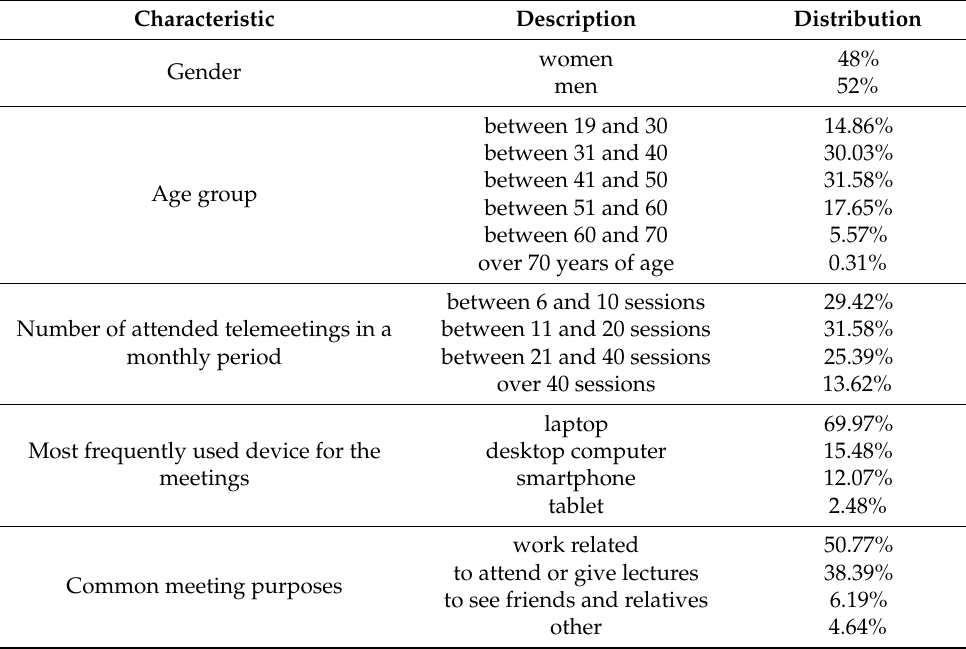
Table 1. General information about the survey participants and their meetings.